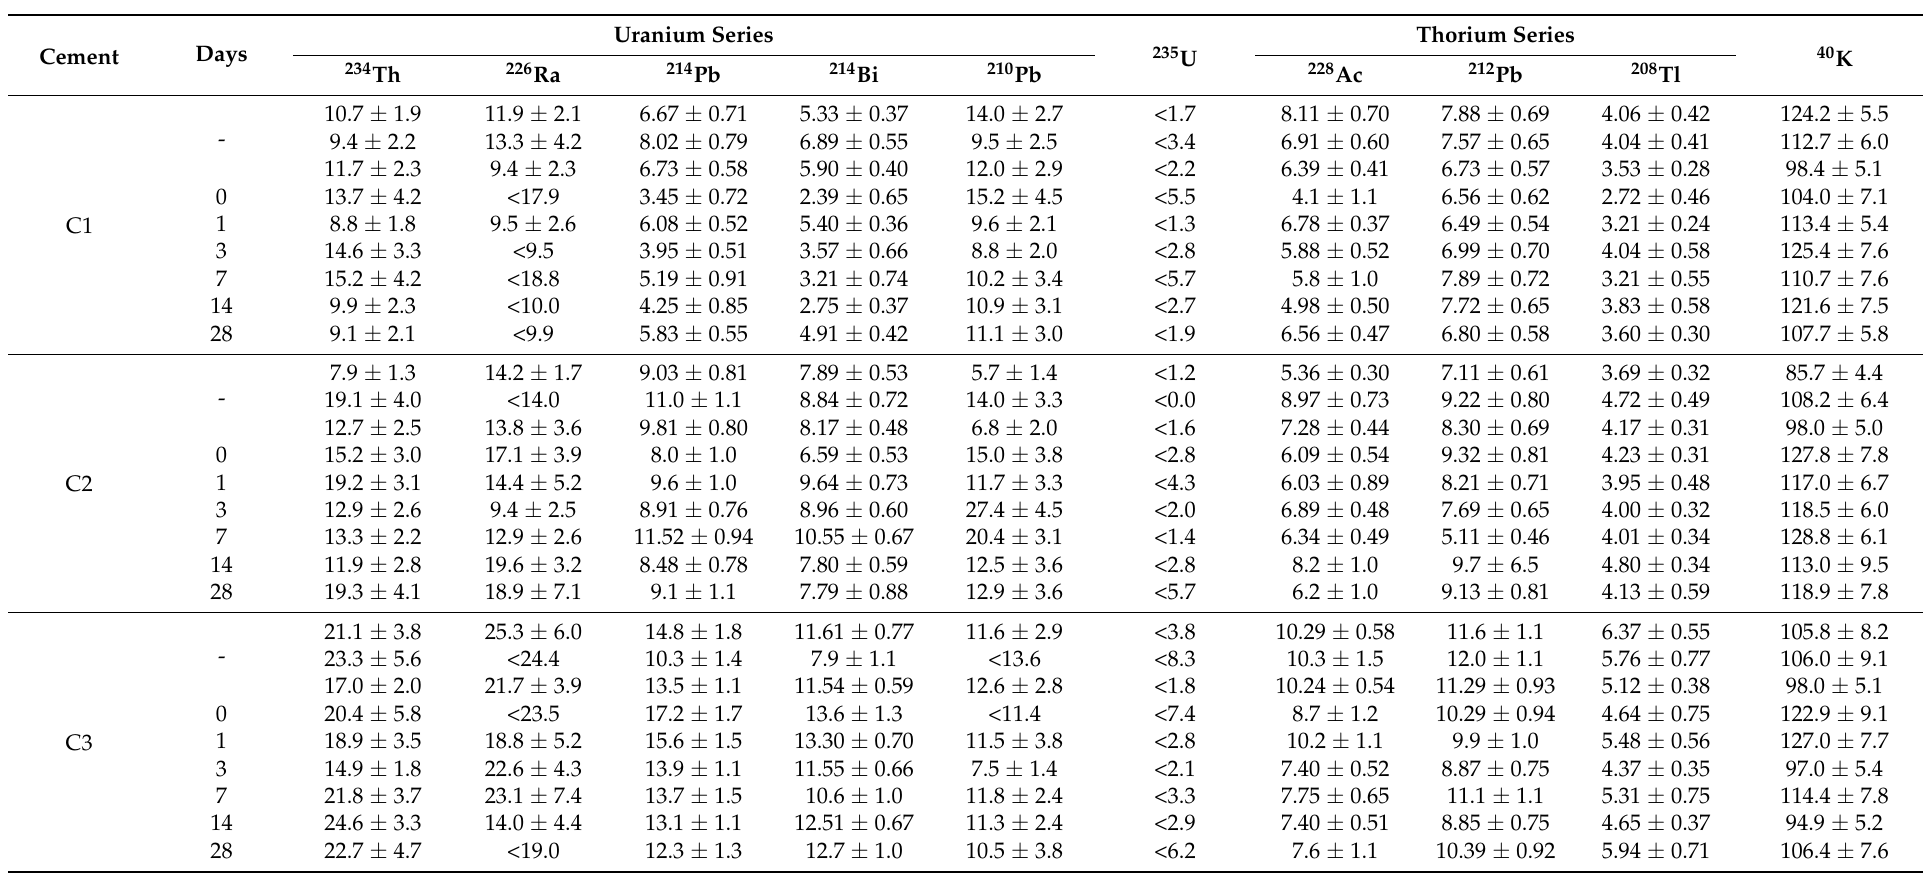
Table 2. Activity concentrations of the prisms of hardened mortars: (a) non-carbonated mortars and (b) carbonated mortars at different curing ages (0, 1, 3, 7, 14, and 28